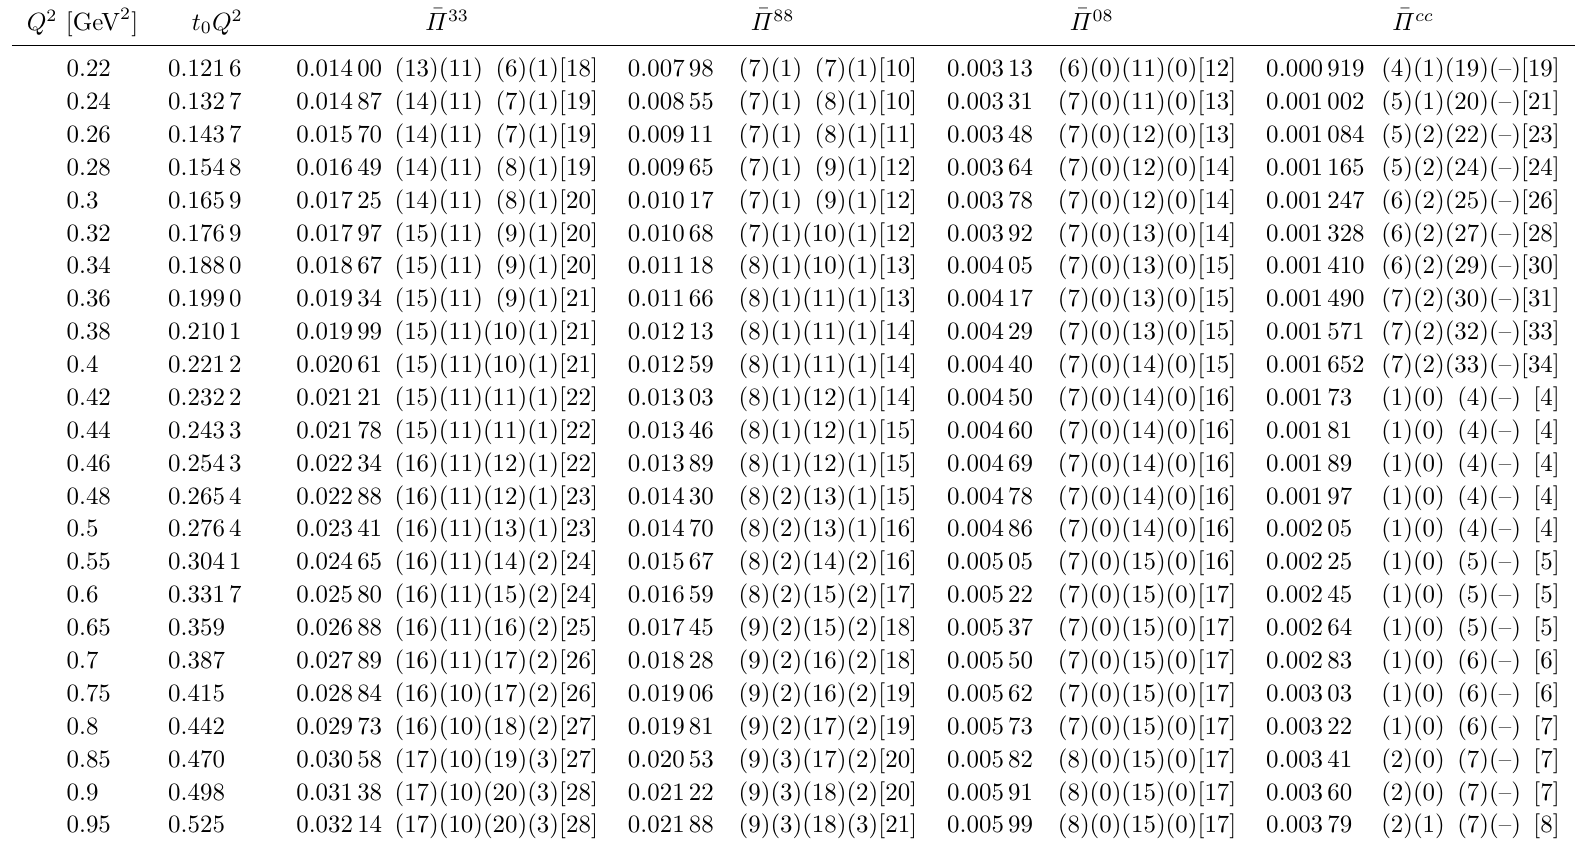
Table 12 . Results for the ¯ Π 33 , ¯ Π 88 , ¯ Π 08 and ¯ Π cc HVP contribution extrapolated to the physical point for all the values of Q 2 sampled. The first quoted uncertainty is the statistical error, the second is the systematic error from varying the fit model estimated in section 4.1.1, the third is the scale-setting error (see section 4.2.1), and the fourth is the systematic from missing charm sea-quark loops (see section 4.2.2). The final uncertainty, quoted in square brackets, is the combination of the previous ones